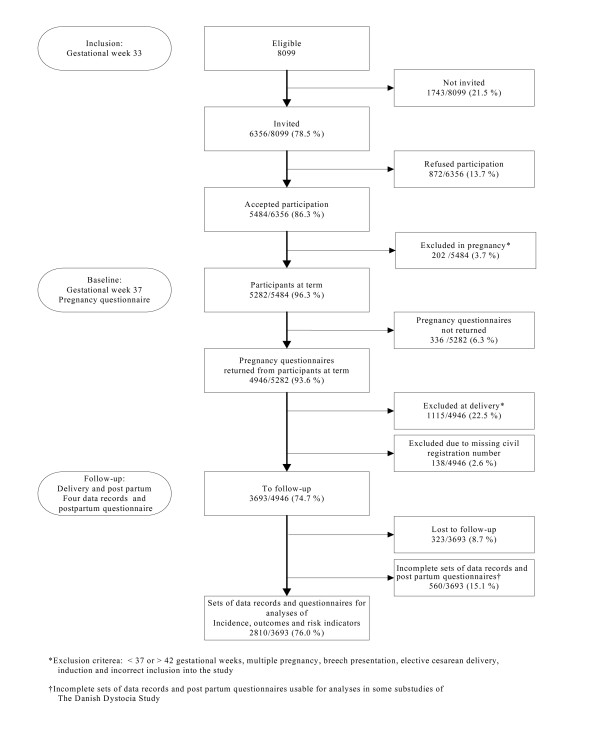
The Danish Dystocia Study Flowchart.